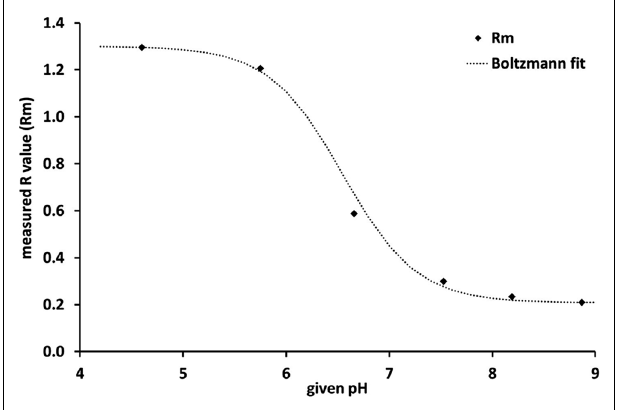
FIGURE 1 | Calibration curve of the planar optodes, where R m is the measured R -value, i. e., the ratio of red to green in the emitted fluorescence response .The steep slope of the Boltzmann fit between pH 6 and pH 7 indicates that the sensor is most sensitive within this pH range.